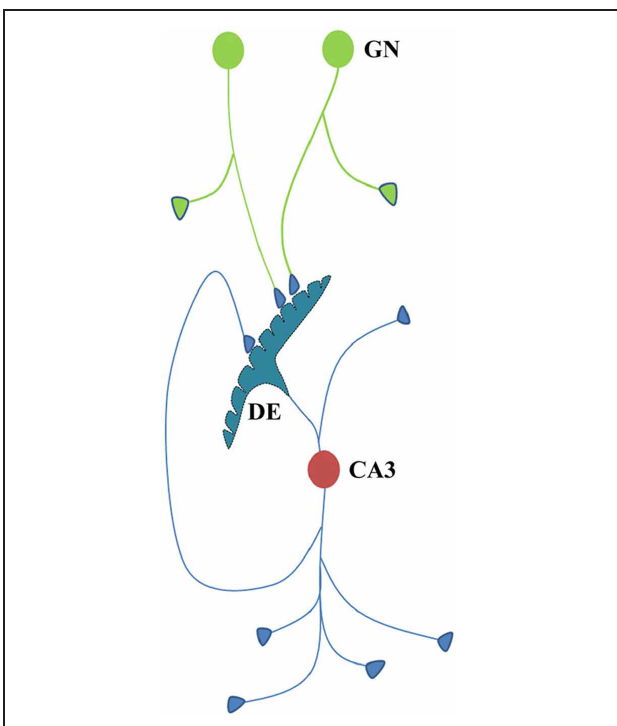
FIGURE 6 | Cartoon showing different connectional features of CA3 neuron. Dendritic excrescences present at the dendritic tree of the CA3 neuron (cell body in red) consist of structurally fused postsynaptic membranes. More than thirty fused spine heads have been reported (Bronson et al., 2008). Dendritic excrescences are also reported across different species. In addition, some of the default motor activity in response to the cue stimuli should also be determined by the output neuronal activity from the CA3 neurons. As some of the axonal terminals of the new granule neurons (cell body in green) are likely to synapse with some of the postsynaptic membrane segments of the excrescences, the resulting spread of activity across the excrescences evokes semblions from the neighboring postsynaptic membrane segments that represent the physical properties of the environment. CA3 neurons also have recurrent collaterals that can induce repeated induction of semblances. Formation of semblances ( Figure 2 ) is not drawn in this diagram. GN, granule neuron; DE, dendritic